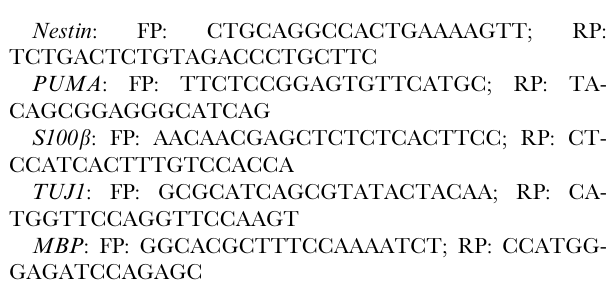
Figure 3. Apoptosis in irradiated NSC is dependent on culture conditions. (A)Flow cytometry analysis for apoptosis-associated DNA fragmentation (Sub-G1) of irradiated NSCs, cultured in standard self-renewal medium, or supplemented with BMP2 (20 ng/ml), or switched to BDNF- containing Neuronal differentiation medium. Error bars: SD. (B)Representative immunofluorescence analysis of GFAP expression in non-irr and irr NSC subjected for 24 h to FCS. DNA was stained with DAPI. Magnification: 40 6 . (C)Gene expression analysis of astrocytes derived by 10% FCS from NSC (FCS d3), and when switched back to NSC culture medium, normalized against self-renewing NSC. Technical triplicates, error bars: SD. (D)TUNEL assay for irradiated NSC at day 3, cultured in unmodified (self-renewal promoting) medium or supplemented with FCS (astroglial differentiation medium), either immediately (d0 + 3) or 24 h after irr (d1 + 2). Error bars: SD.